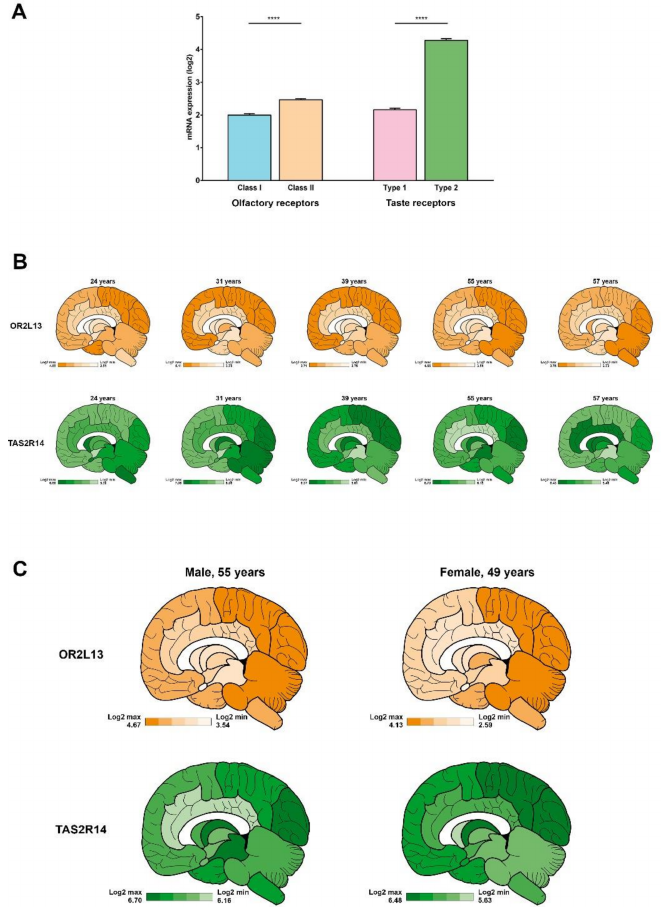
Figure 2. Comparative expression of olfactory and taste receptor transcripts in the human brain, and inter-individual variations in transcript expression. ( A ) global expressions of class I, class II ORs, and type 1 and type 2 TASRs in the whole brain of a 31-year-old Caucasian male. ****: p < 0.0001 (non- parametric Mann–Whitney test). ( B ) Five subjects of various ages were compared. OR2L13 ( top ), one of the most expressed class II ORs in the human brain, is predominantly expressed in the frontal, parietal and occipital cortices but less expressed in regions of the limbic system such as the amygdala, basal ganglia, or hypothalamus, in all subjects. In contrast, the expression pattern of TAS2R14 ( bottom ) varies a lot between subjects ( bottom ). Maximum and minimum expression values are indicated in the bottom left panel for each representation. ( C ) Comparative expression and regionalisation of the OR2L13 ( top ) and TAS2R14 ( bottom ) genes between a male and a female subjects of comparable ages. Maximum and minimum expression values are indicated in the bottom left panel for each